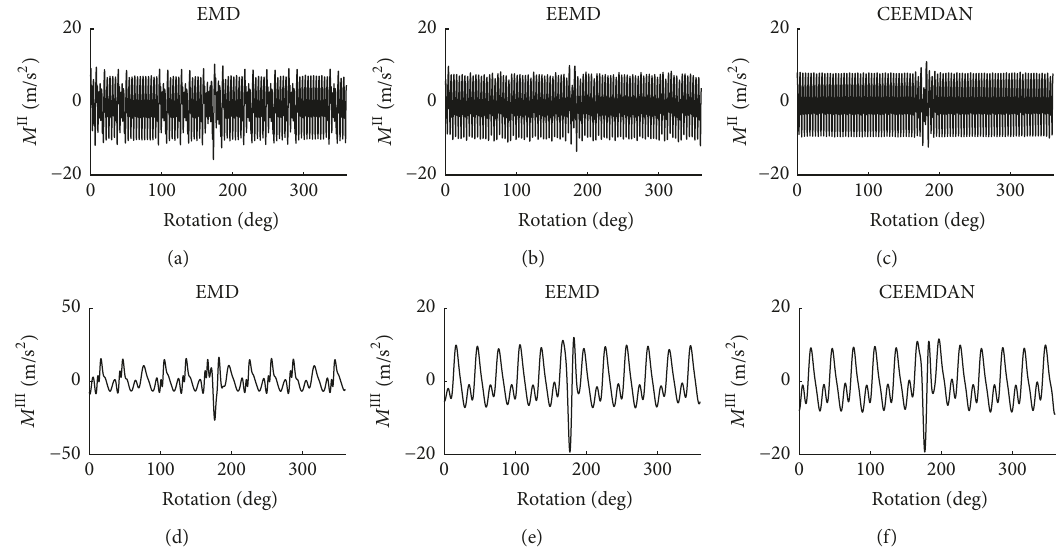
Figure 11: Representative signals for (a–c) gear II and (d–f) gear III in the case of the simulated signal with localized fault in gear III.